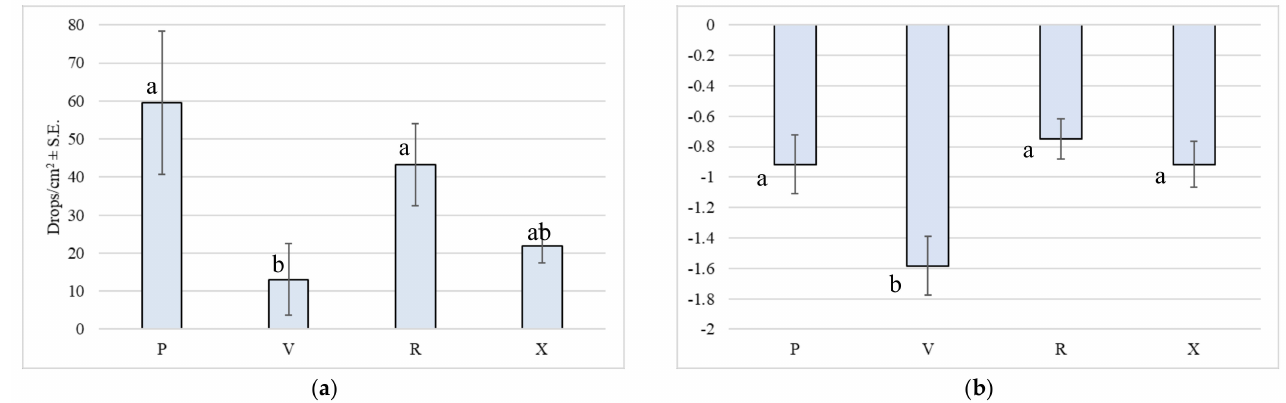
Figure 7. Average values ± standard error of the number of droplets per cm 2 ( a ), and of the visual scores for the WSP placed at a height of 6 m ( b ) (the difference between the means is not statistically significant for the means with the same